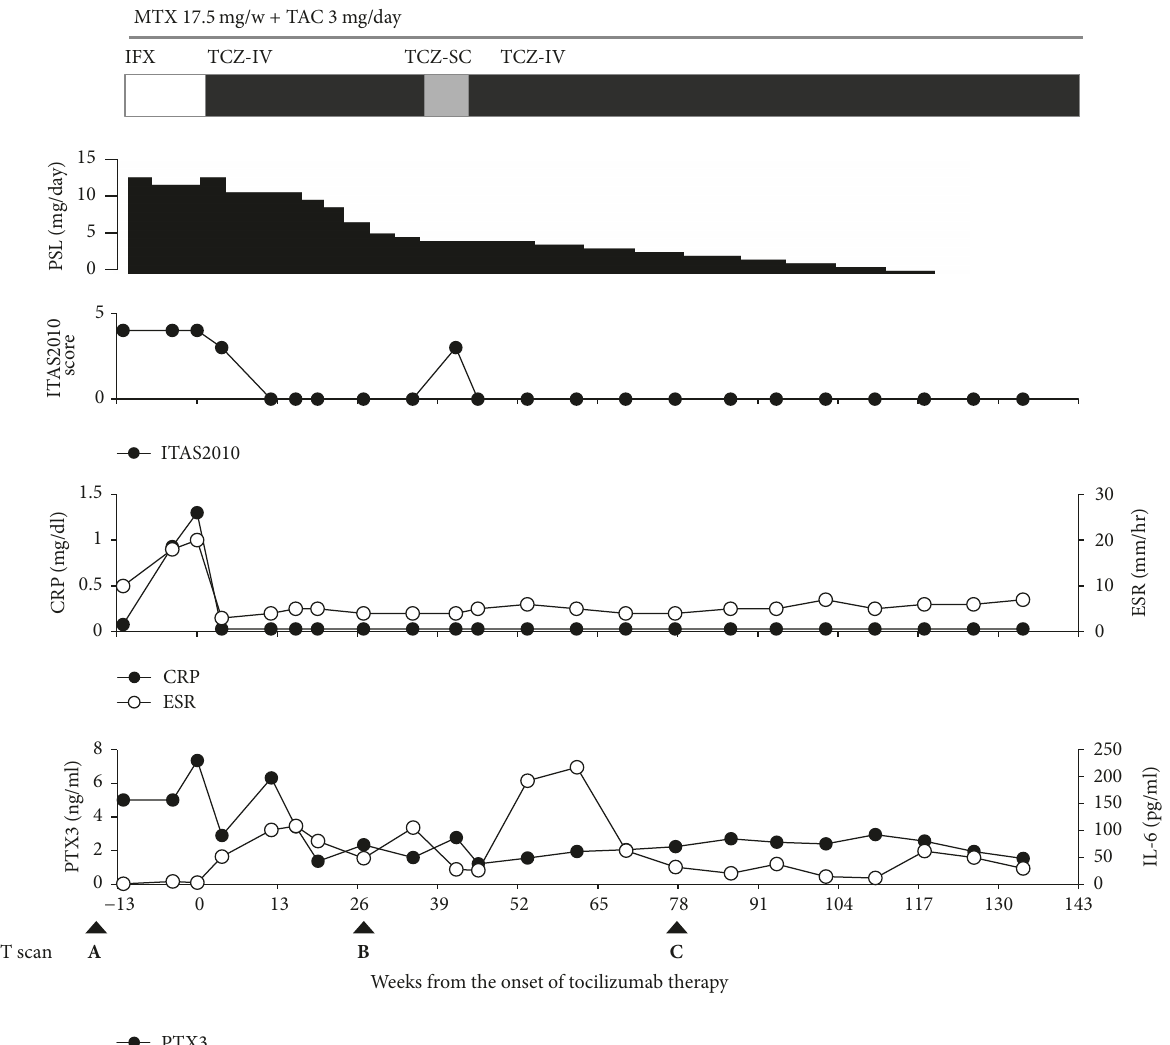
Figure 1: Changes in disease activity, biomarkers, and treatment during anticytokine biologic therapy. Infliximab (IFX) was administered at a dose of 6 mg per kilogram of body weight every four weeks (white bar). Intravenous tocilizumab (TCZ-IV) was administered at a dose of 8 mg per kilogram of body weight every four weeks (black bar), and subcutaneous tocilizumab (TCZ-SC) was administered at a dose of 162 mg per body weight every other week (gray bar). CRP, C-reactive protein; ESR, erythrocyte sedimentation rate; IL-6, interleukin-6; ITAS2010, The Indian Takayasu Activity Score 2010; PSL, prednisolone; PTX3, pentraxin-3.